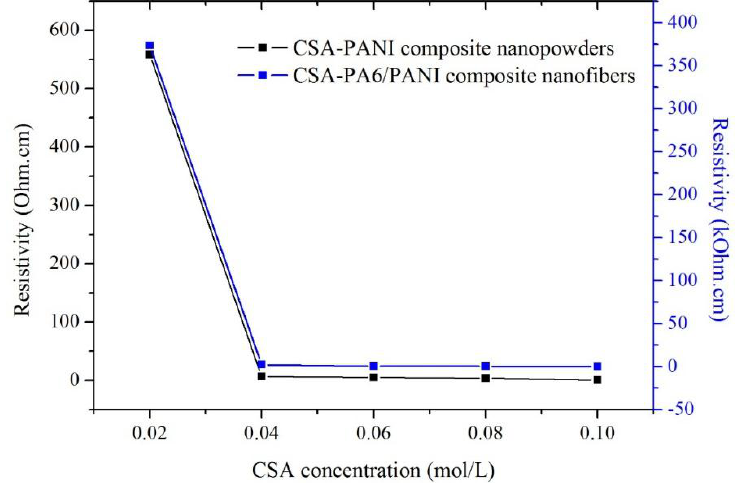
Figure 5. The resistance of CSA-PANI nanopowders and CSA-PA6/PANI composite